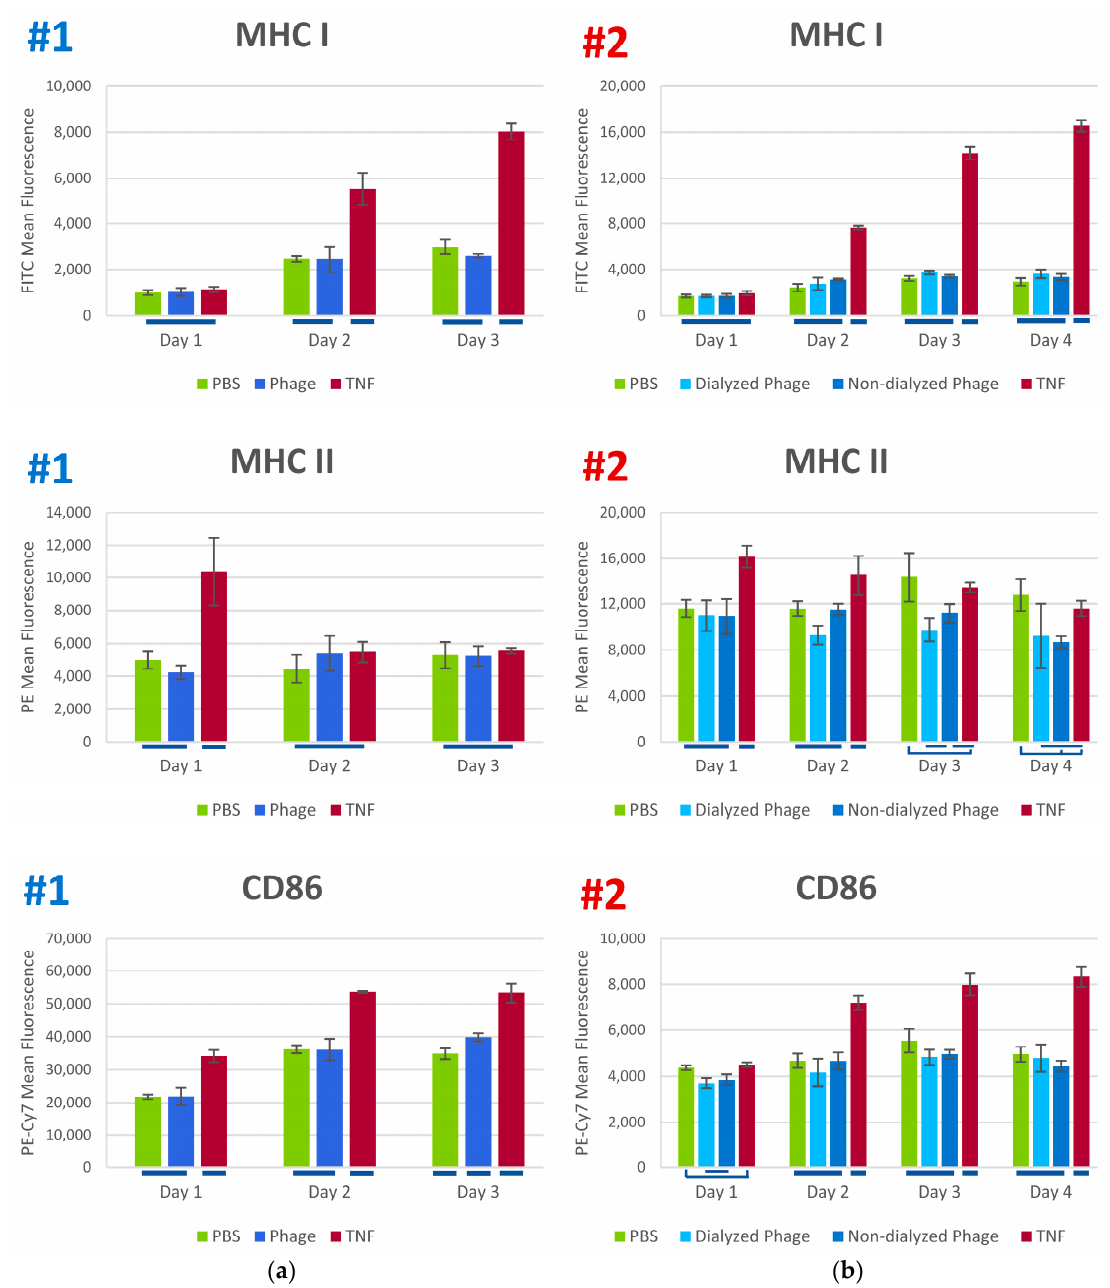
Figure 2. Examples of expression of antigen-presenting and costimulatory surface markers (MHC I, MHC II and CD86) in response to phage K, PBS (negative control) and TNF (positive control) in experiments #1 ( a ) and #2 ( b ). Tukey grouping indicated by lines under bar graphs. p values can be found in Supplemental Tables.